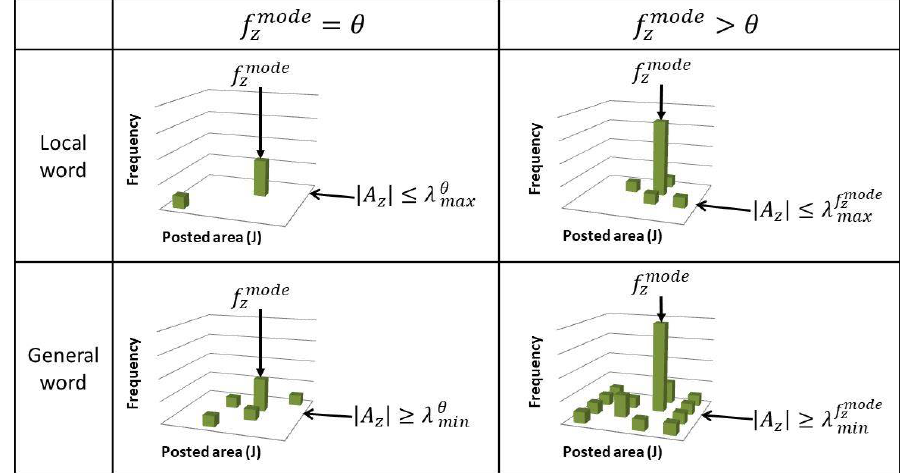
mode mode z max and λ f z for determining local/general words min